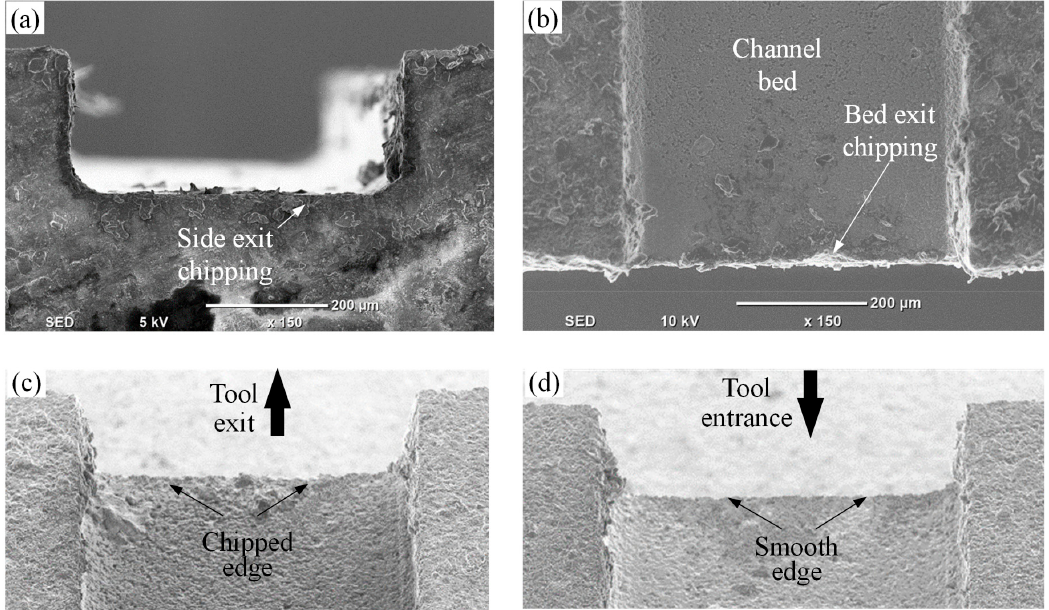
Figure 13. A comparison between entrance and exit edge chipping: ( a ) a typical micrograph of side edge chipping; ( b ) a typical micrograph of bed edge chipping; ( c ) edge chipping at the tool exit; and ( d ) edge chipping at the tool entrance edge.